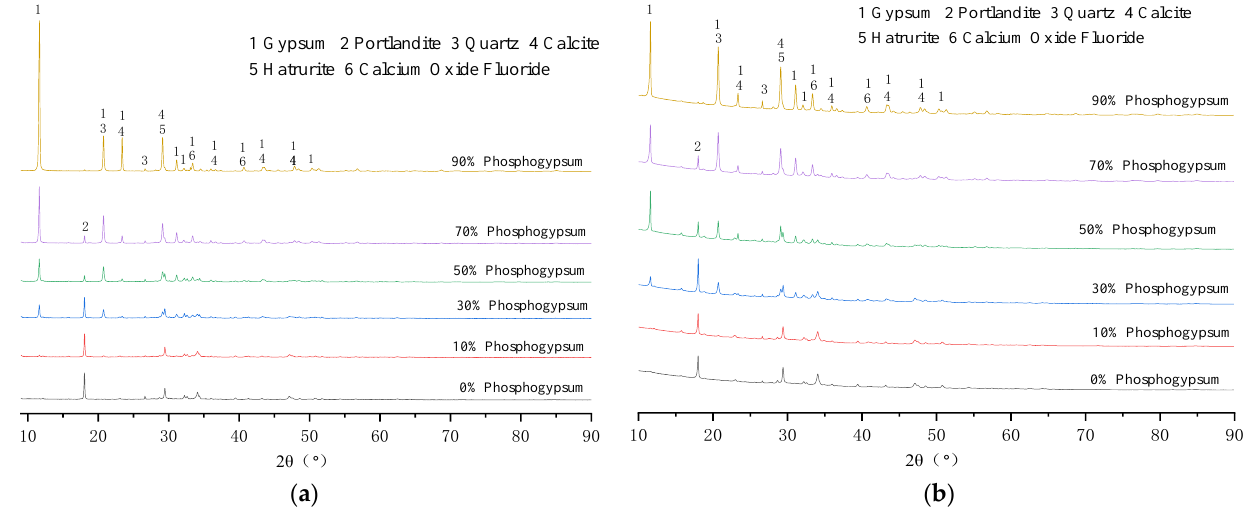
Figure 6. Hydration products of composite cementitious material: ( a ) 3 days; ( b ) 28 days .